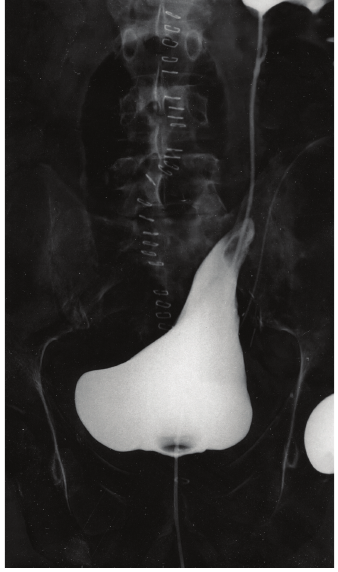
Figure 2: Postoperative cystography following resection of the left pelvic ureter, removed “en bloc” with recurrence of sigmoid carcinoma in a 63-year old man. Extensive bladder mobilization on the left side is